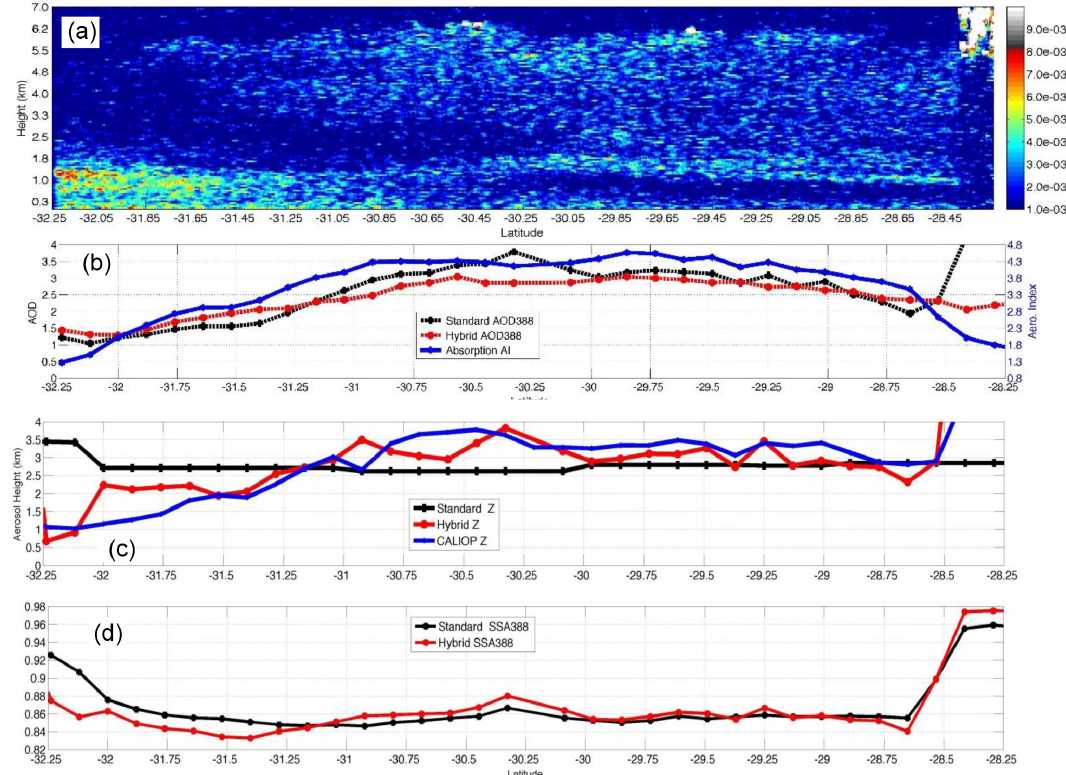
Figure 9. OMI and MODIS retrievals along the CALIOP profile in the south sector of Fig. 8a. The CALIOP 1064nm attenuated backscat- tering profile (a) shows two distinct aerosol layers: one near the surface (0–1.6km) to the south and an elevated layer in the north section (1 to 6km). (b) shows the MODIS-extrapolated or hybrid (red) and standard OMAERUV (black) AOD388 along with the AI (blue). (c) shows the aerosol layer assumed by the OMAERUV algorithm (black), obtained directly from CALIOP in (a) (blue) and using the hybrid method (red). (d) displays the SSA388 from OMAERUV (black) and from the hybrid method